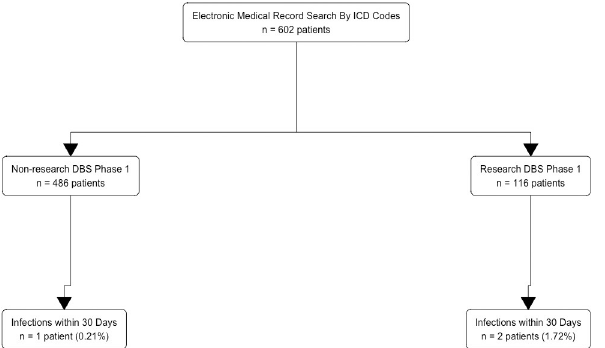
Fig 1. Acquisition of cases by medical record review. Flowchart demonstrating the acquisition and filtering of deep brain stimulation (DBS) procedures (or cases) from the electronic medical record (EMR) using International Classification of Diseases (ICD) codes. There is no statistically significant difference between the non-research and research DBS groups in the 30-day infection rates (0.21% vs. 1.72%; p = 0.0966,